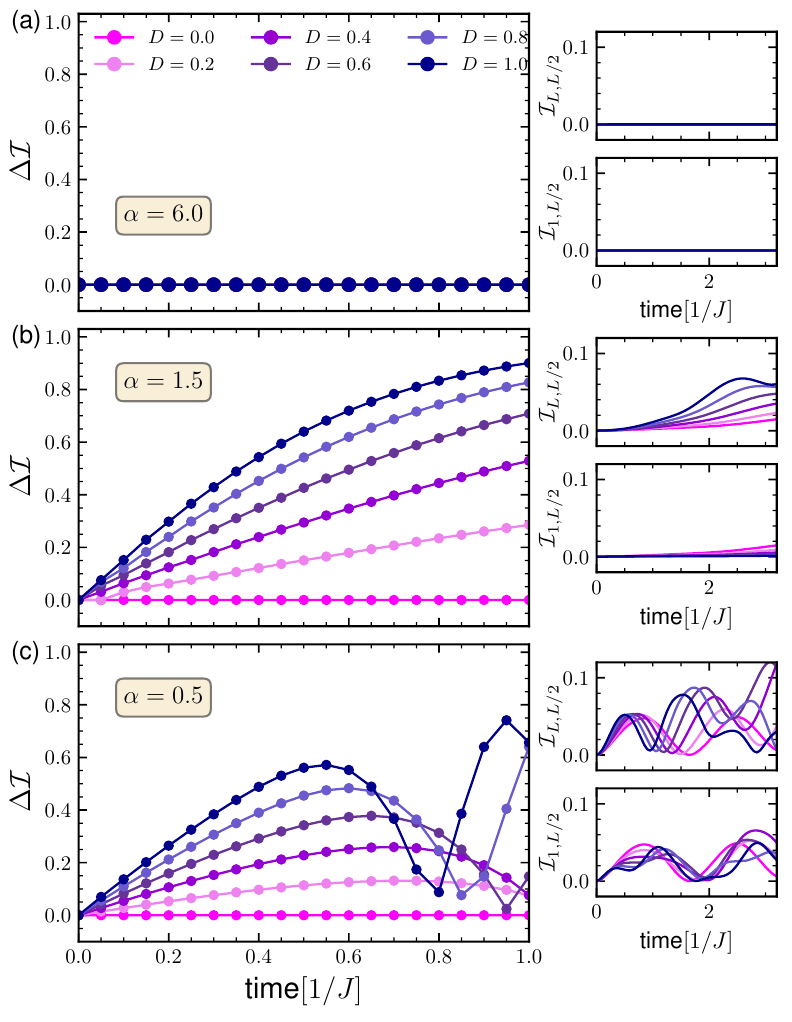
Figure 7: (colour online) Main panels (a-c) show time evolution of quantum mutual information polarization ∆ between spin at centre (place of initial perturbation) I and the spins located at edges of chain. Side panels correspond to the quantum mutual information of the main panel. Data for chain size L = 23 and ∆ = I ij